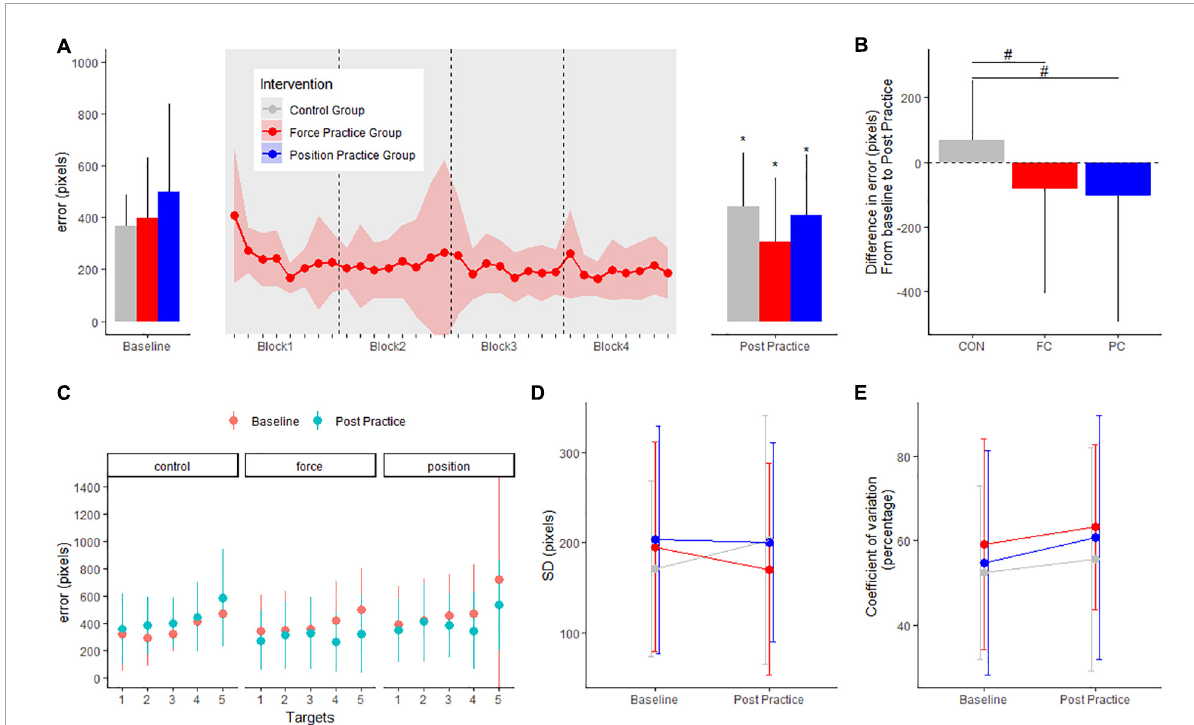
FIGURE3 Mean errors (pixels) at baseline and post practice conditions from force control task in the three groups in the main experiment are depicted in panel (A) : the position control practice group (blue), force control practice group (red) and control group (gray). Learning curves from the four blocks of force control practice is shown in panel (A) . The delta changes (error) in the force control task are shown in panel (B) . Target specific mean errors (pixels) in the force control task at baseline and post practice in the three groups are shown in panel (C) . Standard deviations from mean error in the three groups are shown in panel (D) while coefficient of variation in percentage are shown in panel (E) . *Denotes a significant difference within group and # denotes significant difference between groups.